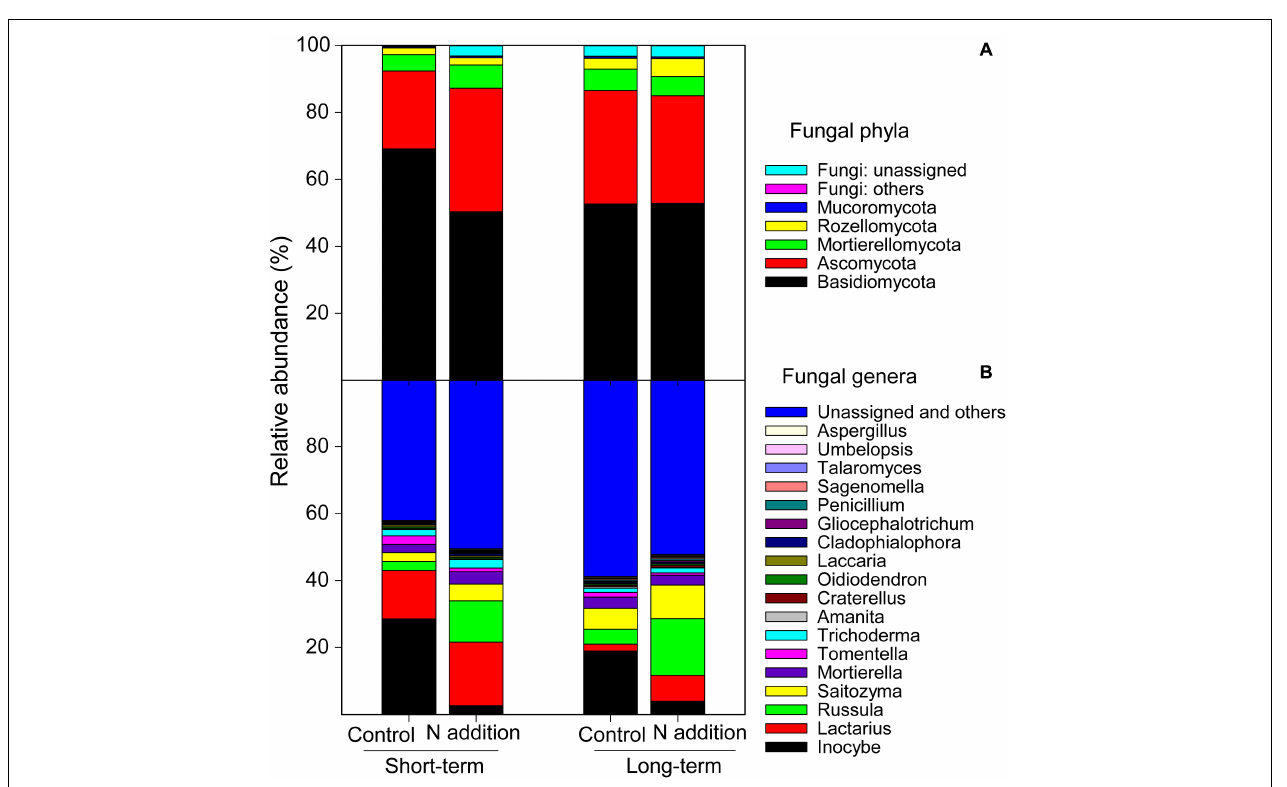
FIGURE 1 | Relative abundance of major soil fungal phyla (A) and genera (B) at the short- and long-term N addition sites. Phyla and genera with relative abundance > 0.2% are included.